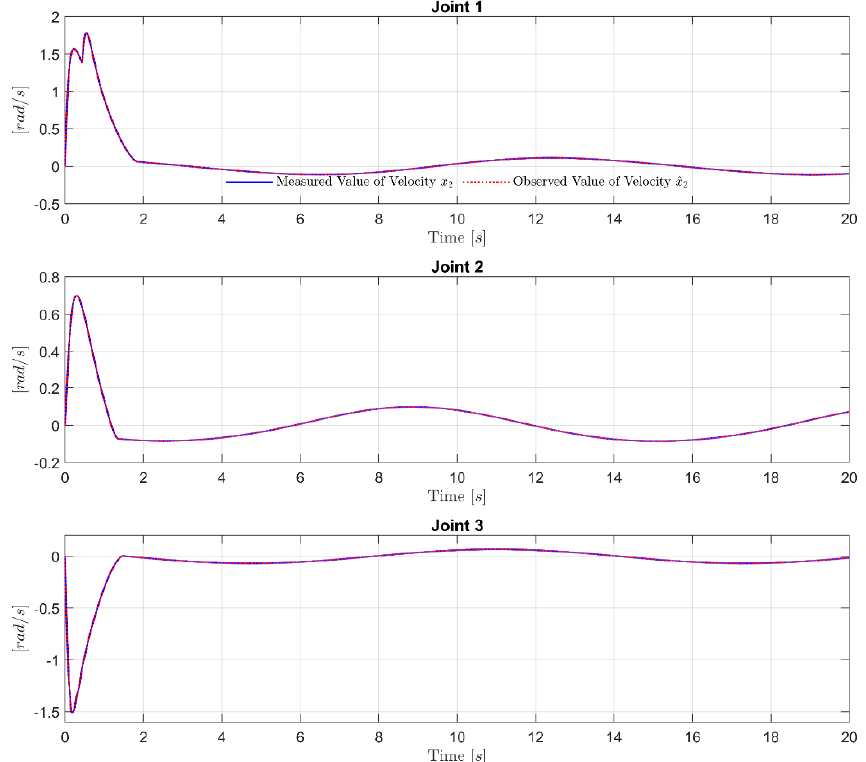
Figure 3. Measured value of velocity x 2 and observed value of velocity ˆ x 2 at each Joint. Figure 3. Measured value of velocity 𝑥 Figure 3. Measured value of velocity 𝑥 (cid:2870) and observed value of velocity 𝑥(cid:3548) (cid:2870) at each Joint. (cid:2870) and observed value of velocity 𝑥(cid:3548) (cid:2870) at each Joint.